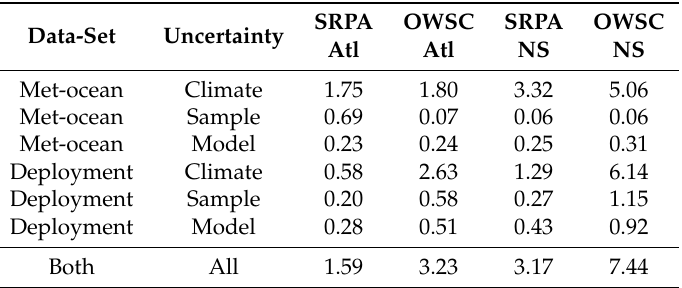
Table 6. Standard deviation of MAEP ( σ MAEP ) as a percentage of ‘true’ MAEP for a deployment length of 12 months and a met-ocean data length of 10 years. First 6 rows are evaluated based on a MCS with only a single uncertainty source enabled. The seventh row is evaluated based on a MCS with all six sources of uncertainty enabled